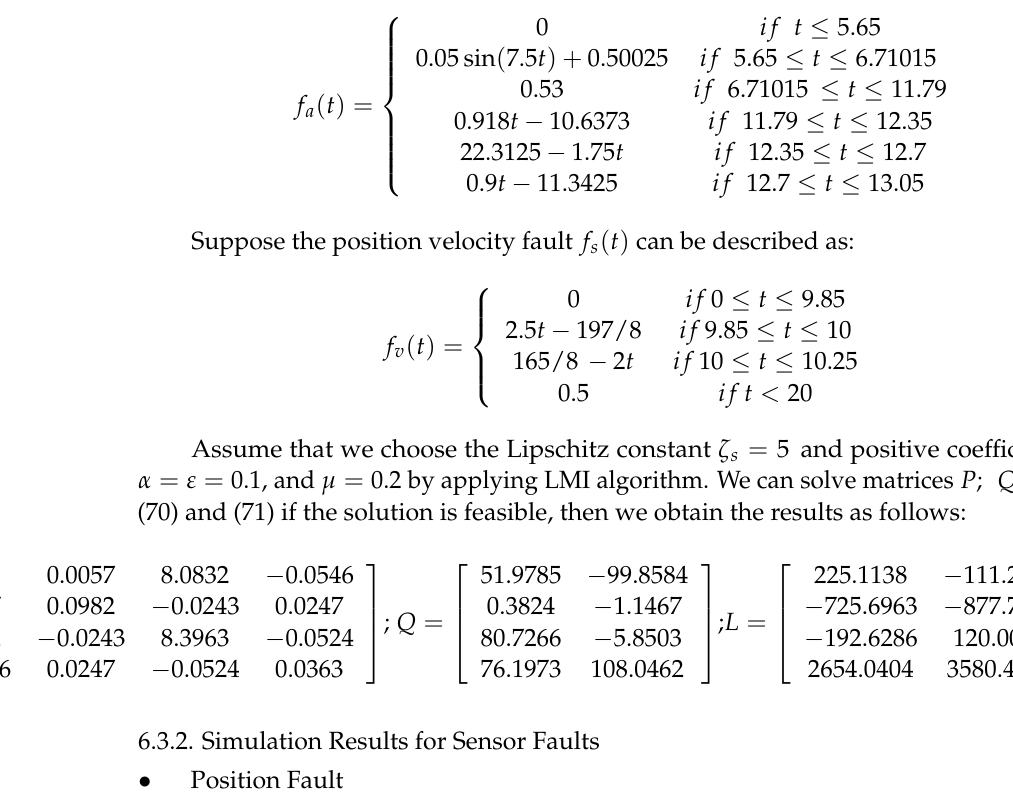
Figure 3b–e, the negative effects of actuator fault on the position response and actuator fault estimation with and without actuator fault compensation are described